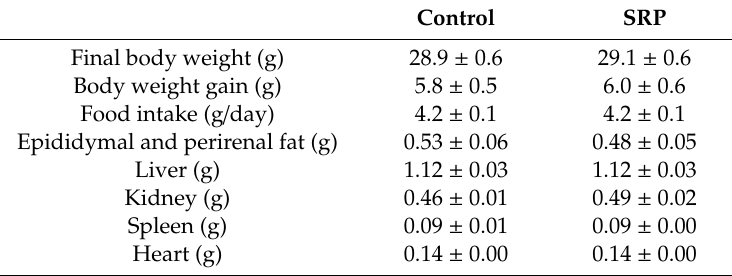
Table 3. Body weight gain, food intake, and tissue